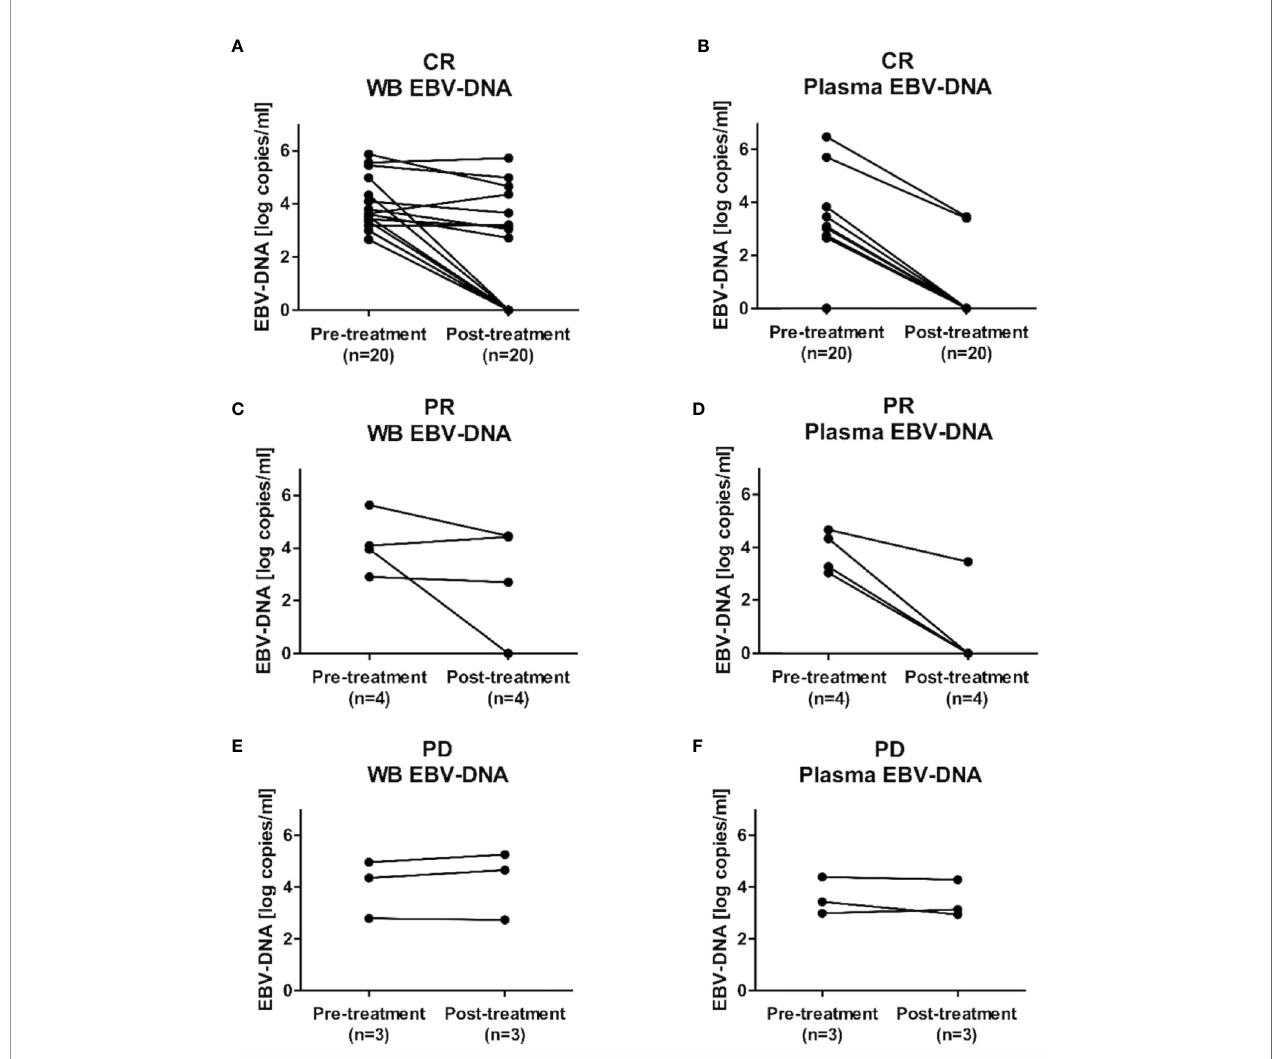
FIGURE 5 | Dynamic changes in Epstein-Barr virus (EBV)-DNA load after treatment completion. Changes in EBV-DNA levels in (A) whole blood and (B) plasma EBV-DNA in patients with complete response (CR), (C) whole blood and (D) plasma EBV-DNA in patients with partial response (PR), and (E) whole blood and (F) plasma EBV-DNA in patients with progression disease